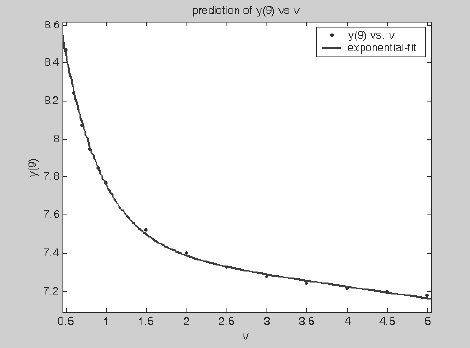
Figure 3 – Graph of prediction of (9) y vs. . v